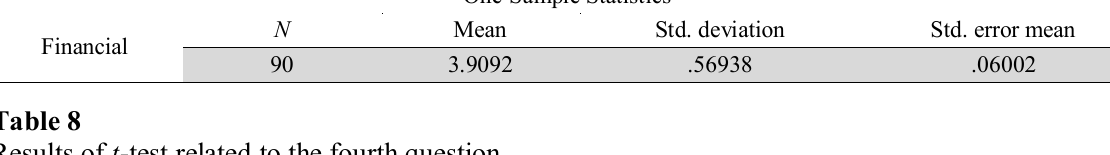
Results of t -test related to the fourth